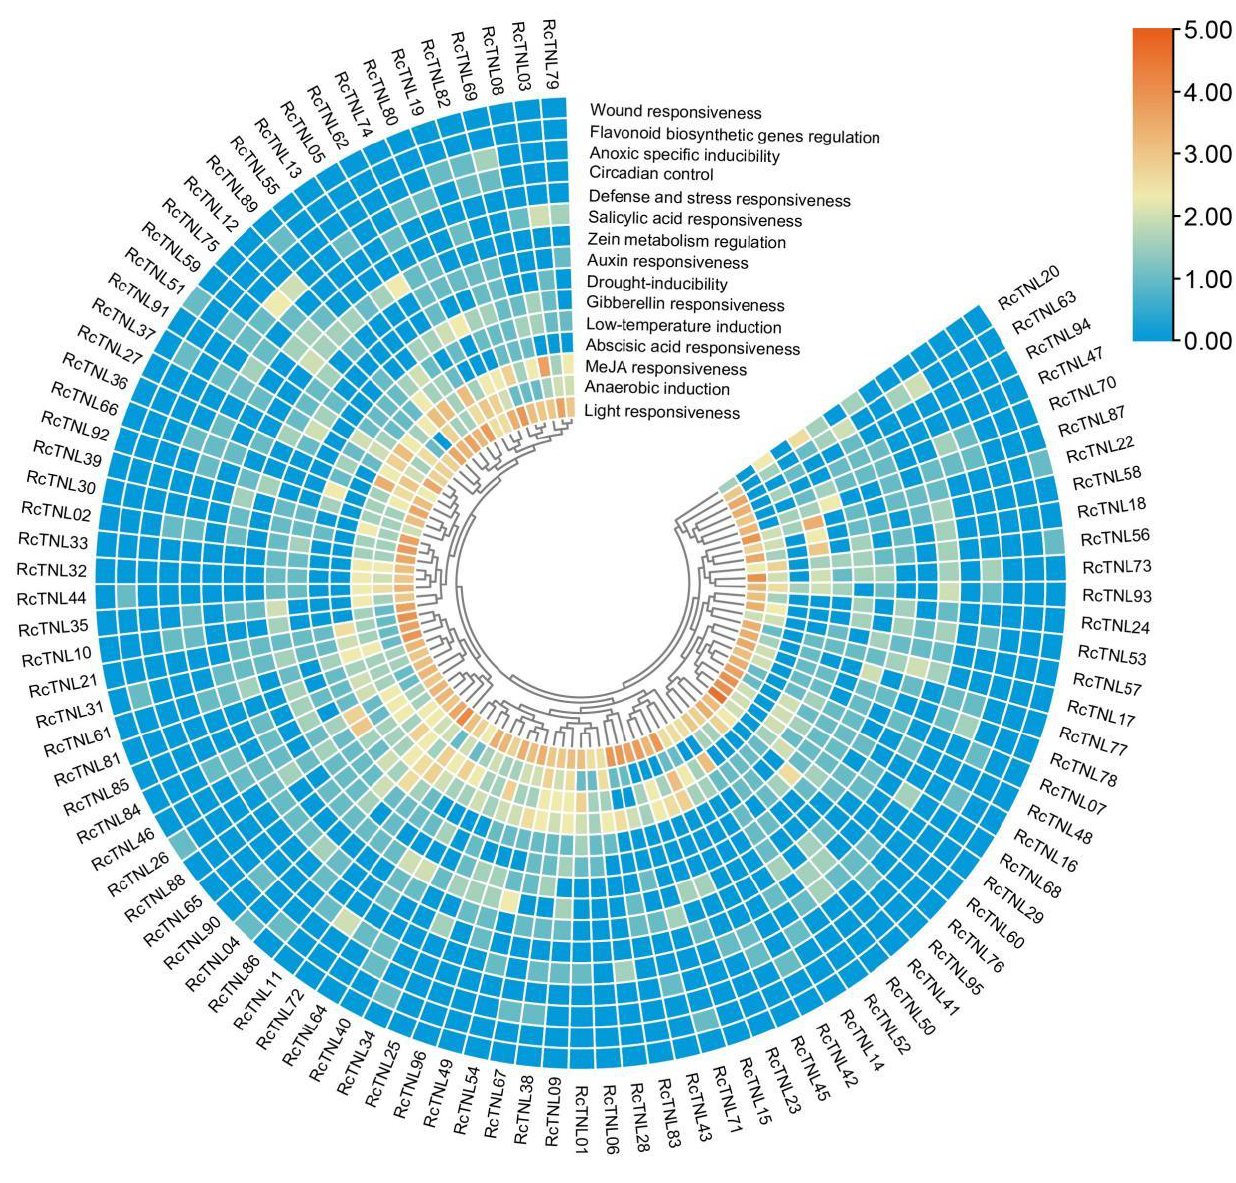
Figure 4. Classification and number of cis-elements in the promoter regions of the RcTNL genes. The heatmap was plotted by taking log 2 fold of the number of cis-elements. The color shift from blue to red indicates an increasing number of cis-elements.